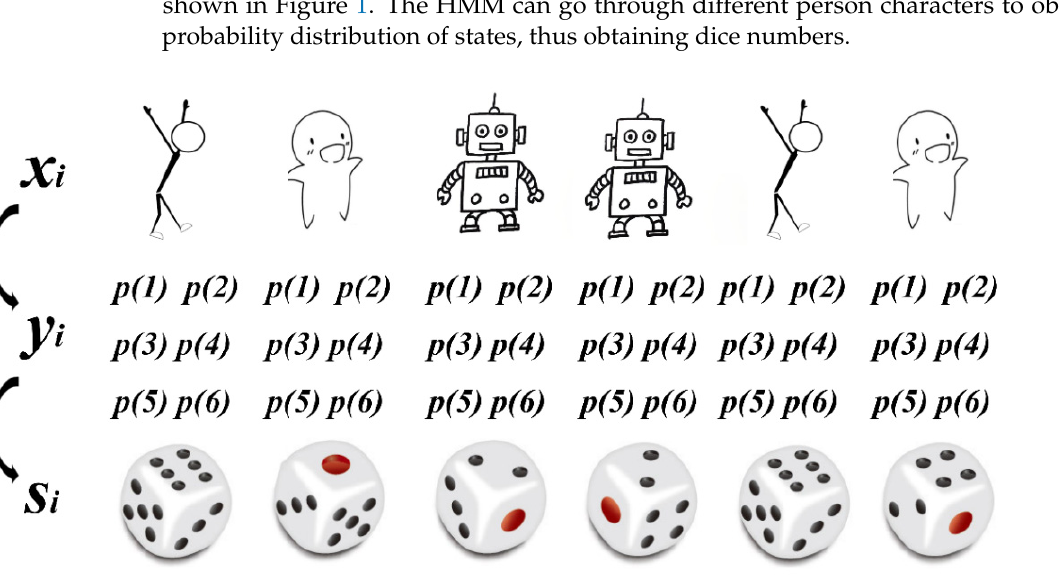
Figure 1. The decoding processing of Hidden Markov Model schematic.